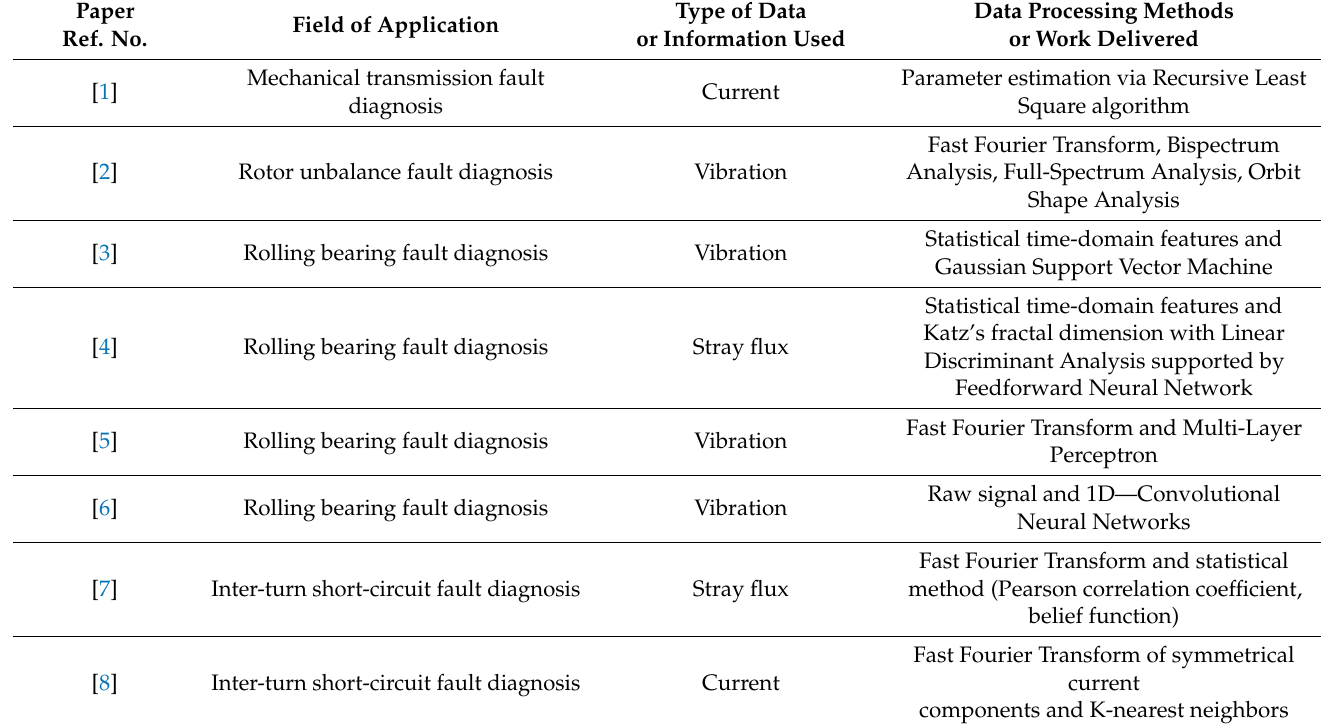
Table 1. Summary of the work reported in the fourteen